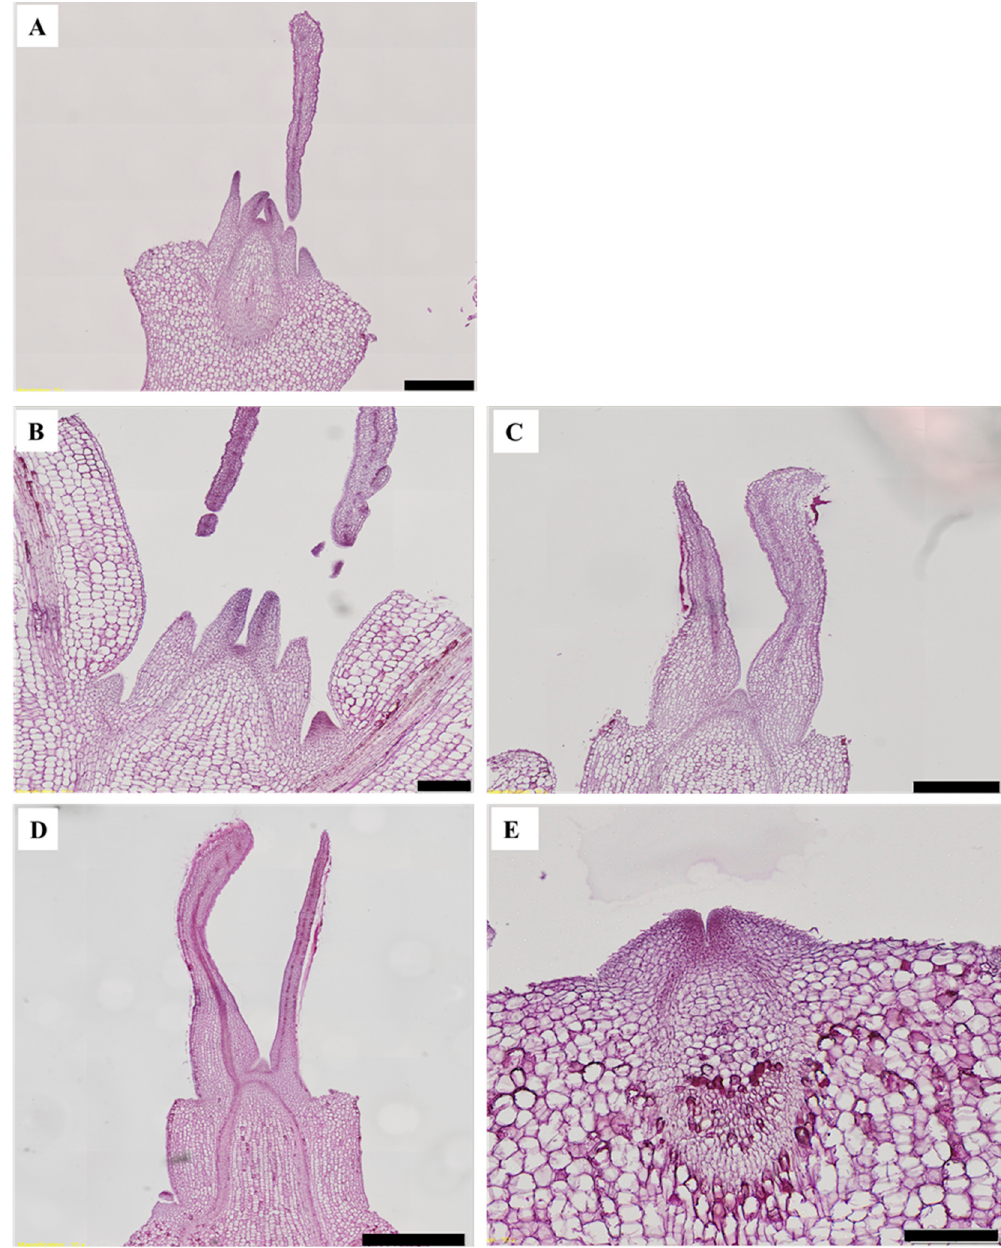
Figure 6. The vertical section of the terminal buds of kalanchoe ( Kalanchoe blossfeldiana ) ‘Lipstick’ grown under NI-B at 10 ( A ) or 20 ( B ) µ mol · m − 2 · s − 1 PPFD; NI-R ( C ), NI-W ( D ), and NI-BW ( E ) at 20 µ mol · m − 2 · s − 1 PPFD for 53 days. Please refer to Figure 1 for details on the NIL quality. Scale bars in A to E indicate 500, 200, 500, 1000, and 200 µ m.